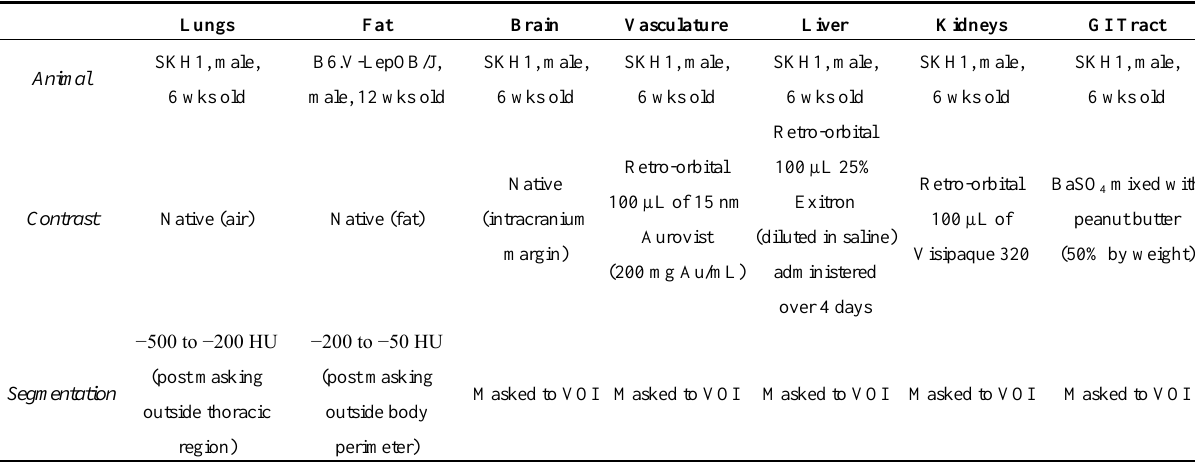
Table 1. X-ray CT experimental